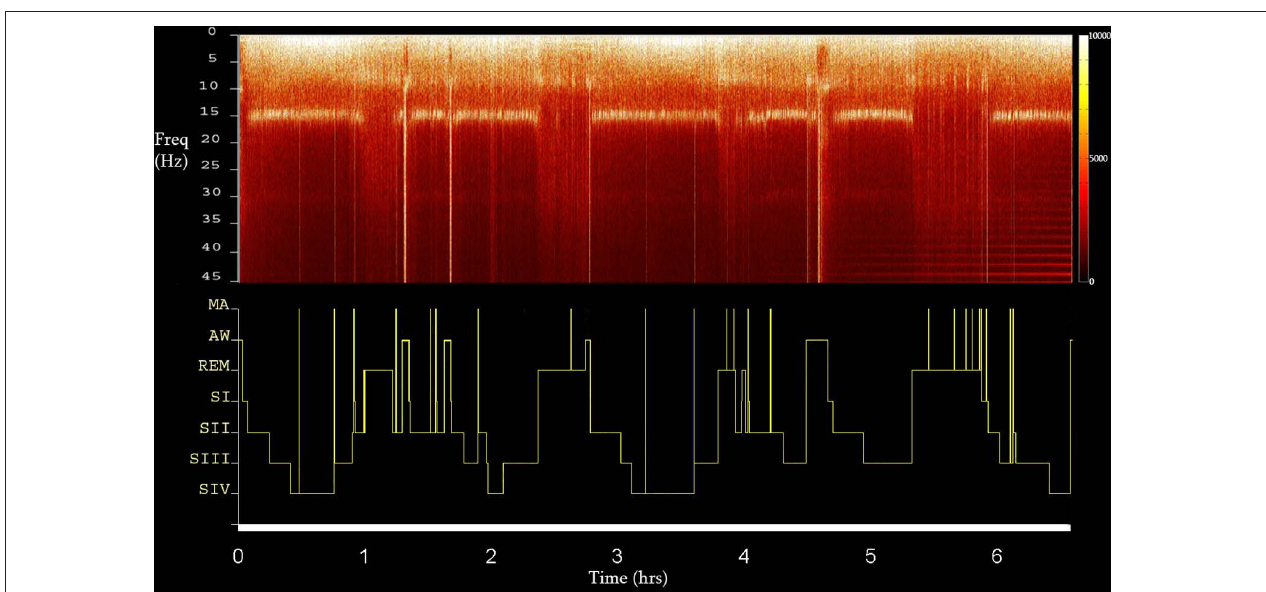
FIGURE 1 | The FFT-based whole Hypnospectrogram derived from the Cz electrode (upper) and the respective Hypnogram (lower) (MA, microarousal; AW, awake; REM, rapid eye-movement sleep; SI-IV, NREM sleep stages 1–4) of Subject 2. Color power bar units are in uV 2